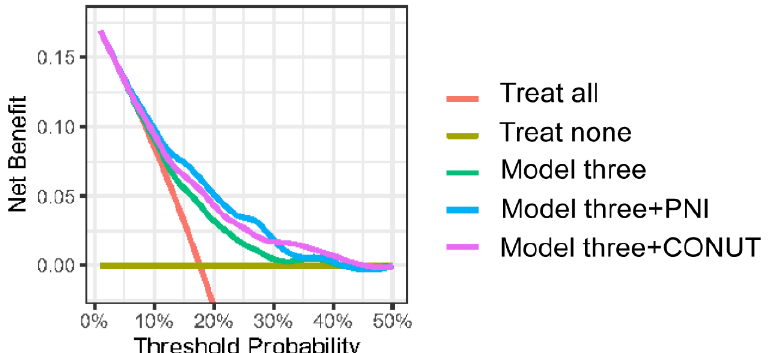
Figure 5. Decision curve analysis for Model three integrating PNI/CONUT features compared with Model three without using the malnutritional index. The blue line representing the model integrating PNI and the purple line representing the model integrating CONUT lie above the other models.